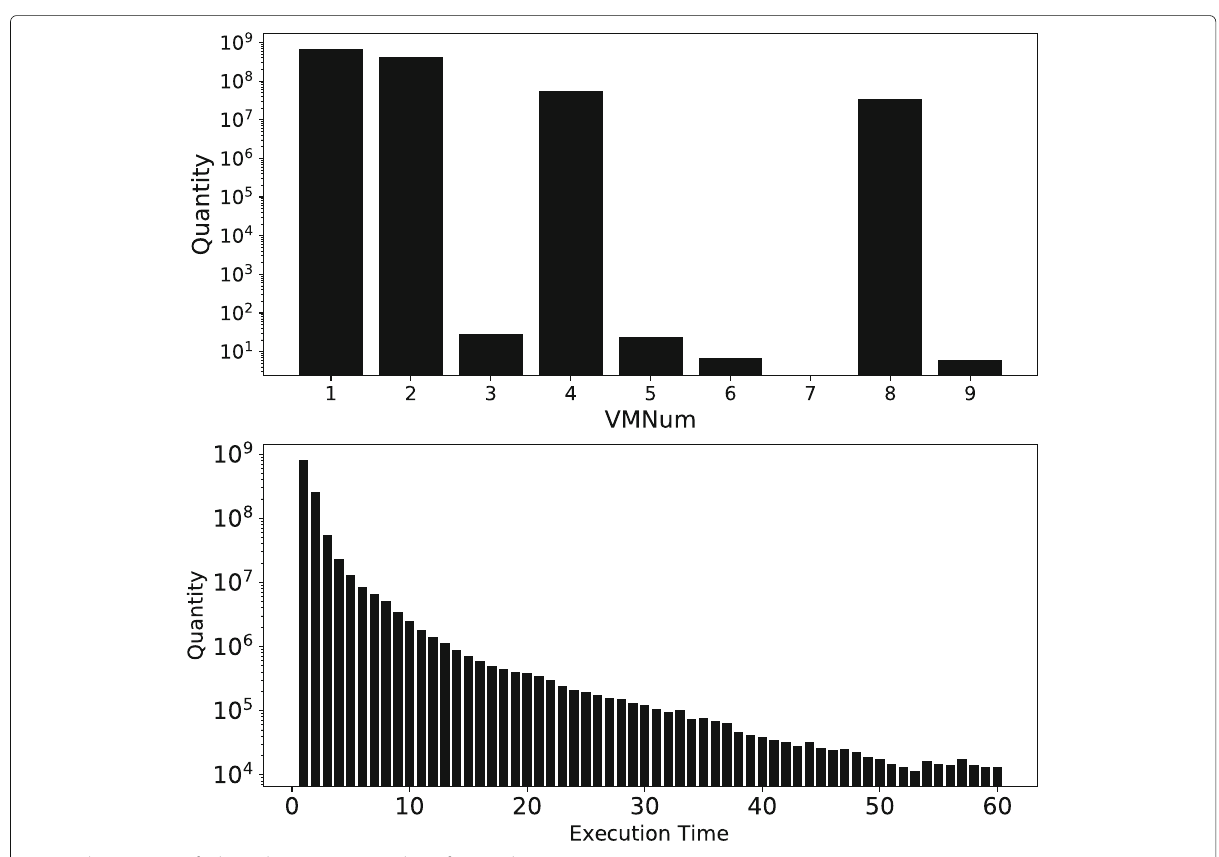
durations in a descending order. Although intuitively sim- ply match them one by one is applicable, it may result in that no paricipants are fully satisfied. For example, the request of buyer winners requesting for 5, 3, 2 timeslots will match the seller winners offering 3, 2, 1 timeslots respectively, such that all the buyer winners can only buy resources for their less important jobs or even buy